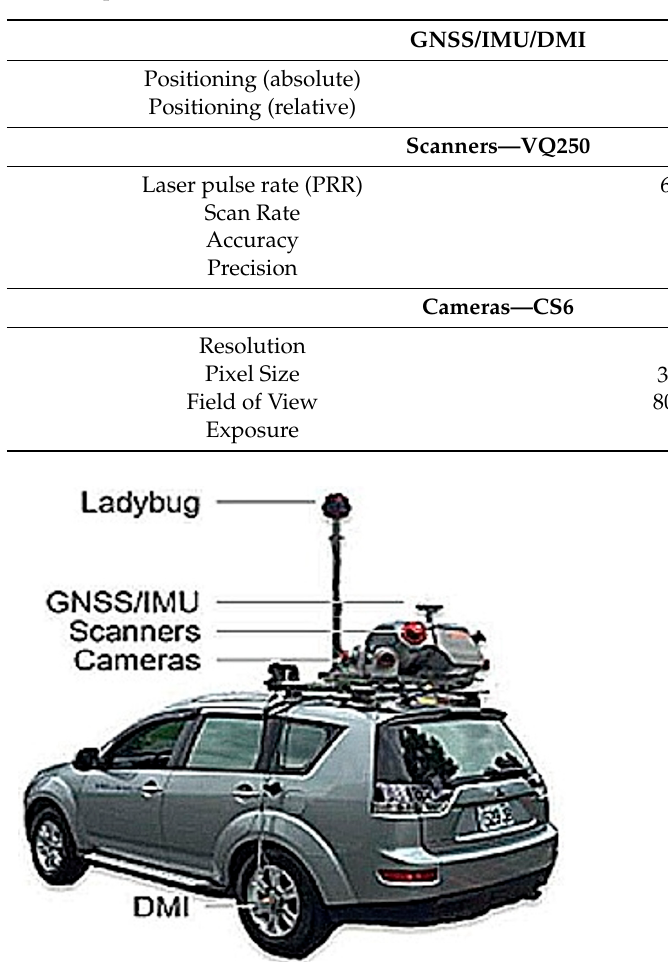
Figure 9. Commercial MLS system equipment. Table 3. Specifications of iMAR